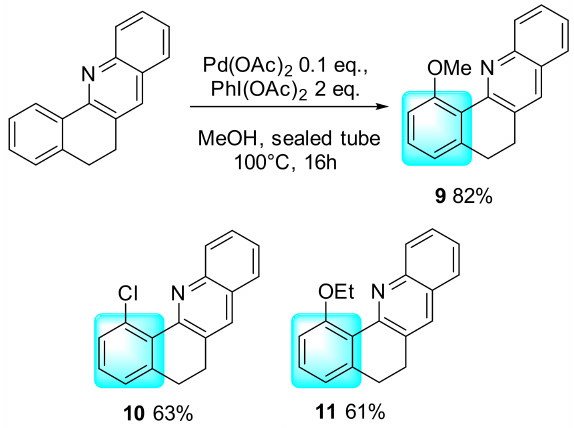
Scheme 2. Determination of best experimental conditions for C-H activation of acridine 4 .